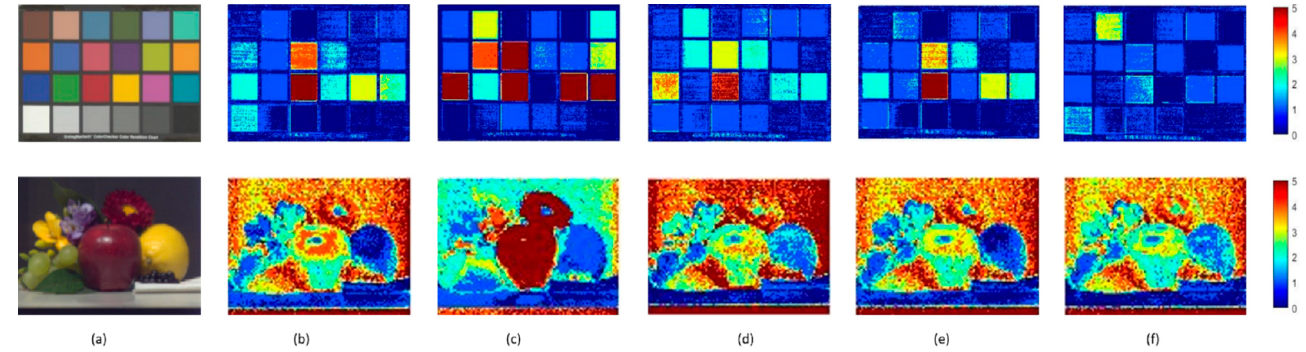
Figure 8. Results comparison of spectral images in different methods using the NokiaN900 as the spectral sensitivity: ( a ) the RGB image, ( b ) PI, ( c ) PCA, ( d ) Wang [37], ( e ) Zhang [32] and ( f ) the proposed.